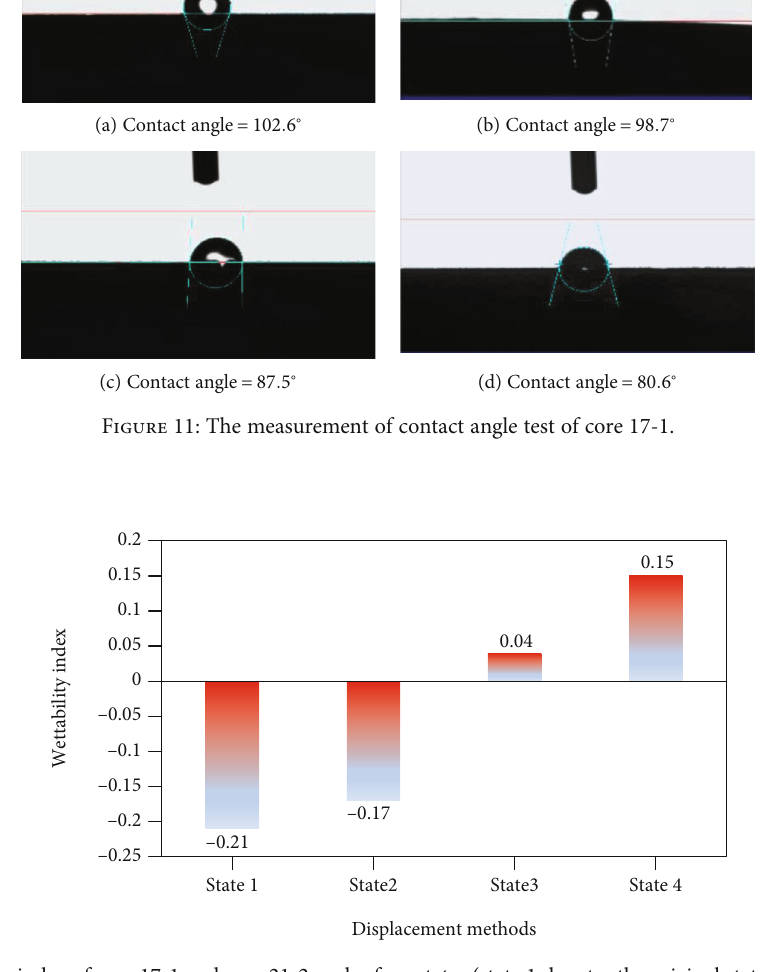
Figure 12: Average wetting index of core 17-1 and core 21-2 under four states (state 1 denotes the original state; state 2 denotes the state of water driving under conventional injection rate; state 3 denotes the state of fracturing by water at high pressure; state 4 denotes the state of fracturing by an oil displacement agent at high